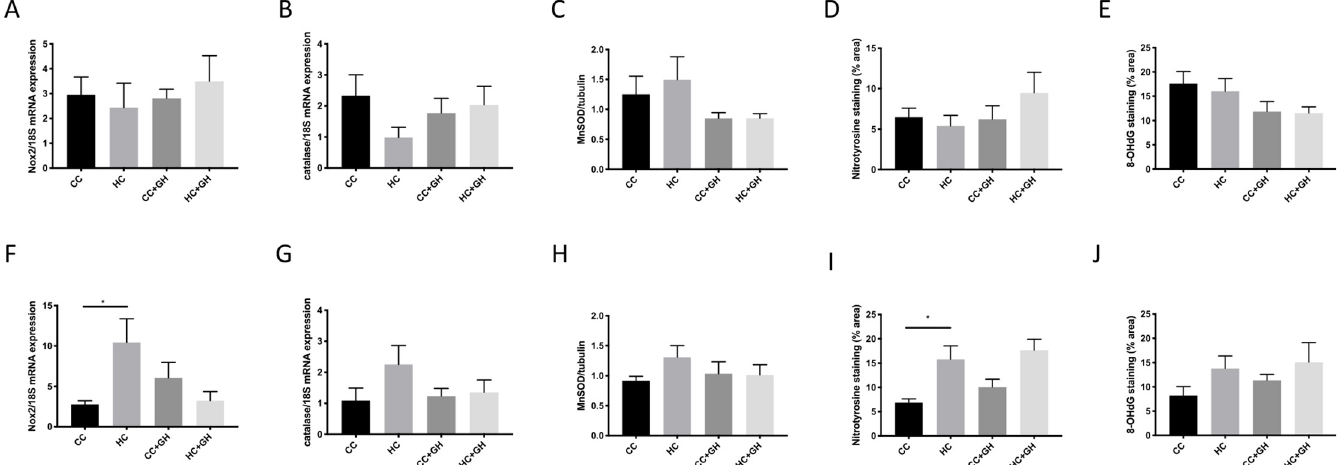
Fig 12. Markers of renal oxidative stress. (A) Nox2 mRNA expression at week 9, (B) catalase mRNA expression at week 9, (C) MnSOD expression measured by western blotting at week 9, (D) immunohistochemistry for nitrotyrosine at week 9, (E) immunohistochemistry for 8-OHdG at week 9, (F) Nox2 mRNA expression at week 32, (G) catalase mRNA expression at week 32, (H) MnSOD expression measured by western blotting at week 32, (I) immunohistochemistry for nitrotyrosine at week 32, (J) immunohistochemistry for 8-OHdG at week 32. Results expressed as mean ± SEM, n = 6. � p < 0.05.